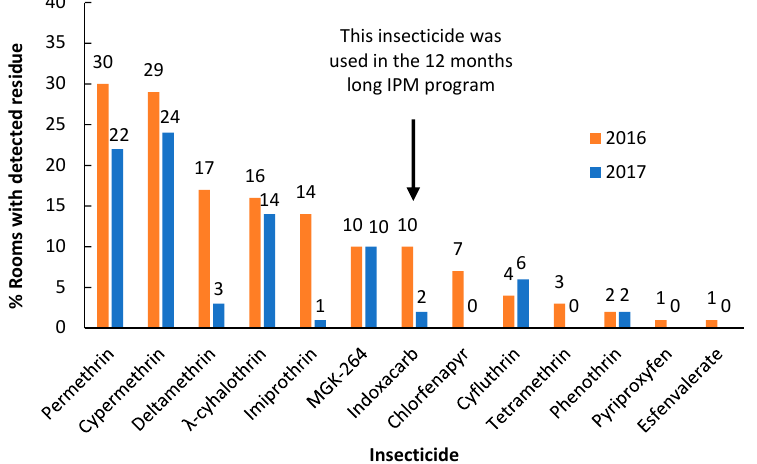
Figure 2. Detection frequency of insecticides in 98 rooms (from 49 apartments) based on floor wipe samples. Only those apartments that were sampled both at 0 and 12 months were included.